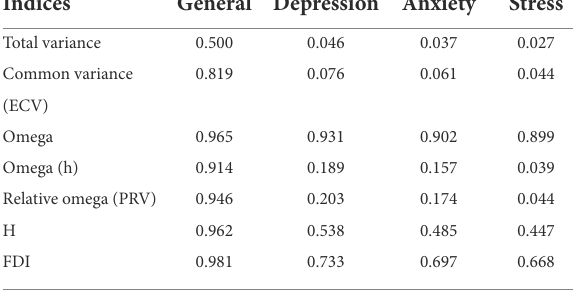
TABLE 5 Omega reliability and ancillary indices for the bifactor model. Indices General Depression Anxiety